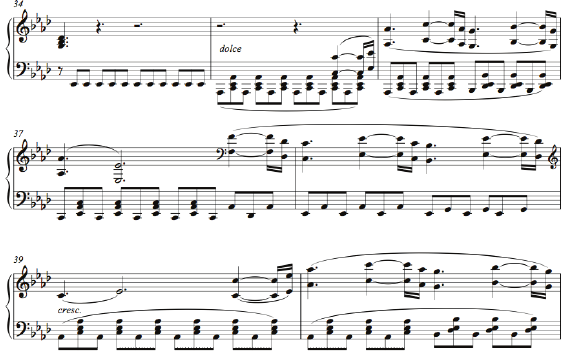
Figure 2 Beethoven, Sonata op. 57. Appassionata, first movement: second theme (bars 34-40) first movement: first theme (bars